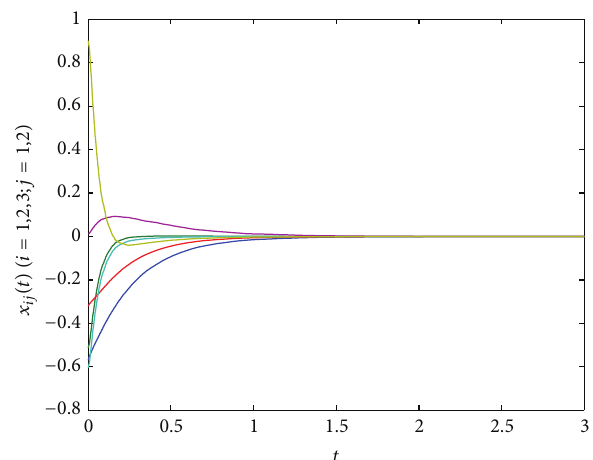
Figure 2: The position state curves of multiagent systems with 𝛼 0 = 0.7 , 𝜇 = 0.7 , and 𝜎 = 0.2 (with partial failure).